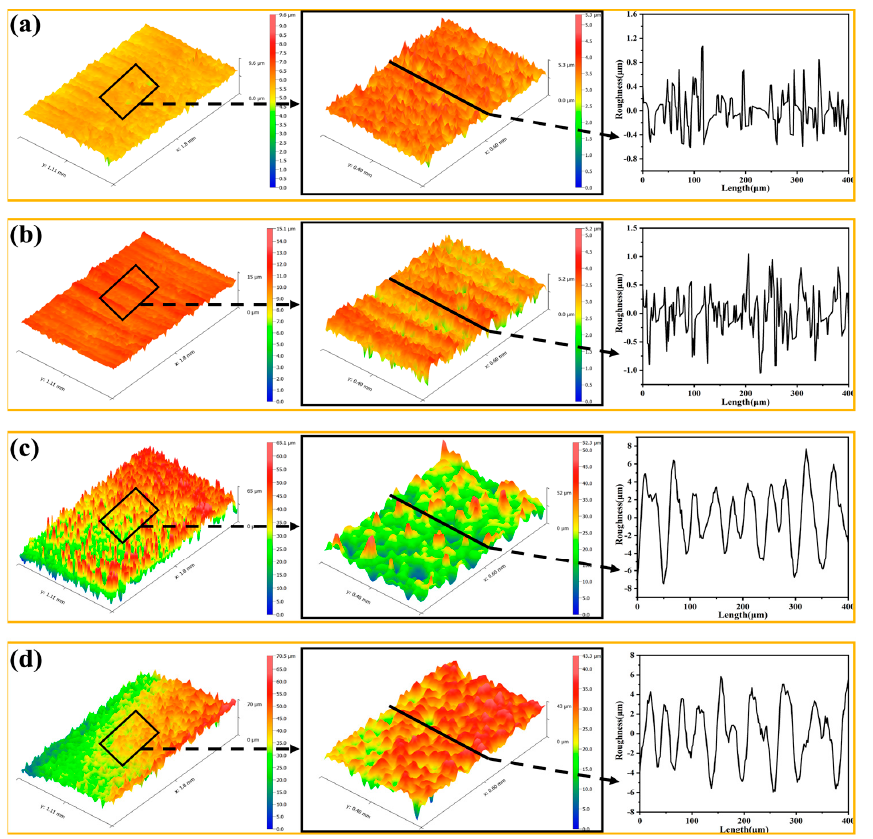
Figure 9. 3D morphology and 2D profile of E-MTES coatings at different deposition potentials: ( a ) − 1.0 V; ( b ) − 1.1 V; ( c ) − 1.2 V; ( d ) − 1.3 V. Roughness Sa values are 0.306 ± 0.044 μ m, 0.431 ± 0.017 μ m, 5.01 ± 0.334 μ m to 8.51 ± 0.244 μ m, respectively.